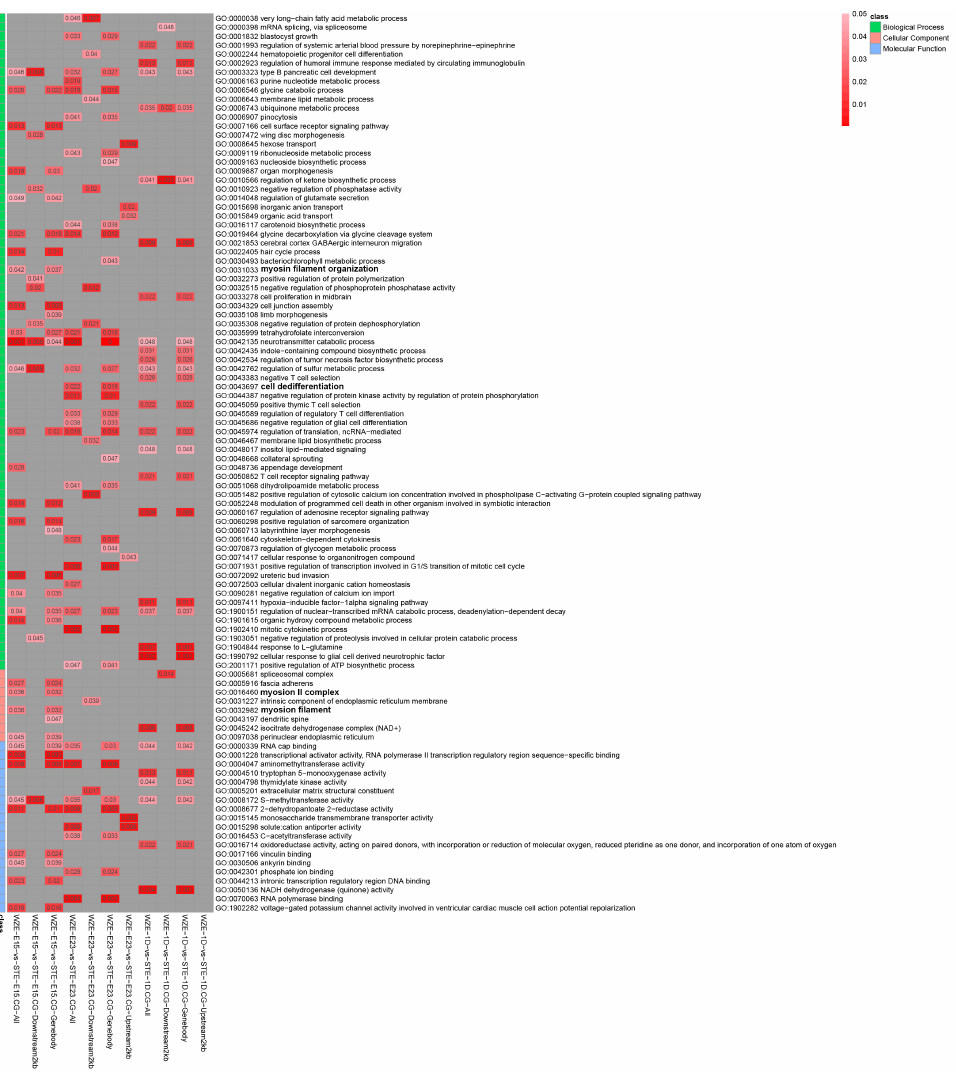
Figure 5. GO analysis of DNA methyation-related DEGs. Myogenesis-related biological processes are marked bold in the figure. Different colors on the left mean different GO classes; different colors and numbers in the figure indicate different corrected p -values; NA, not